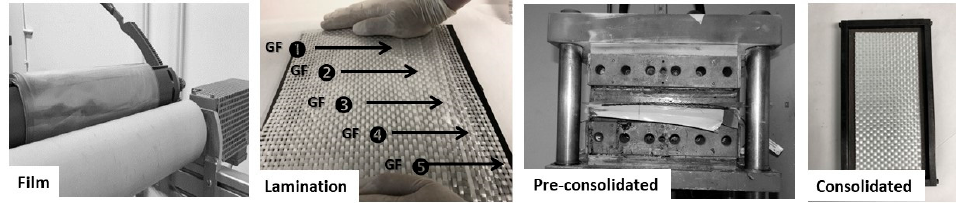
Figure 11. Images of the forming process: film manufacturing of 2.5sPA6, lamination sequence, pre-consolidation and final specimen after compaction.